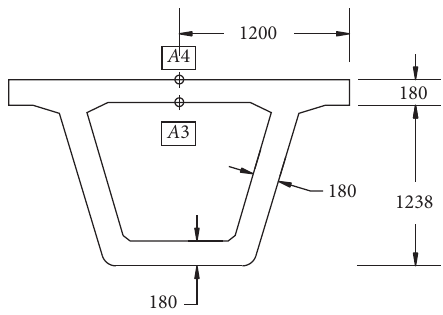
Figure 3: Temperature measuring points A3 and A4 of Section A (unit: mm).